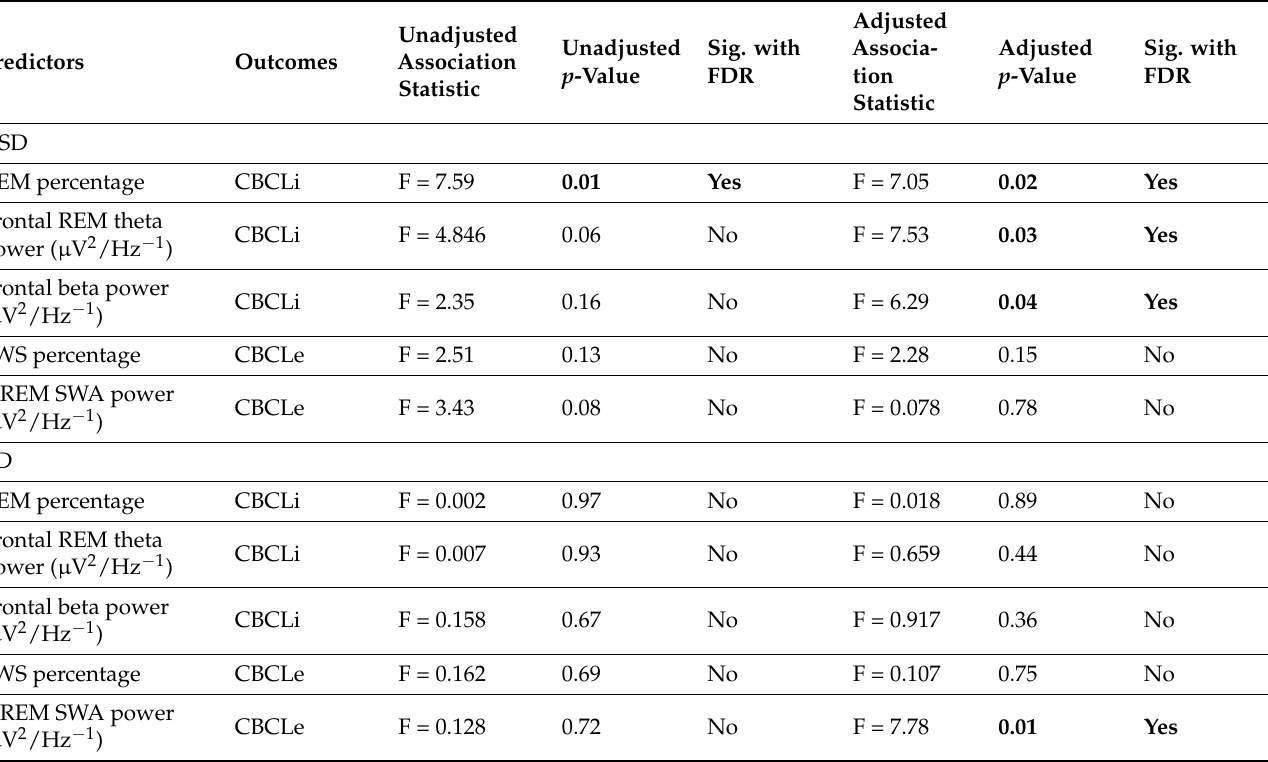
Table 3. Associations between REM and NREM Sleep and CBCL Scores within Groups.